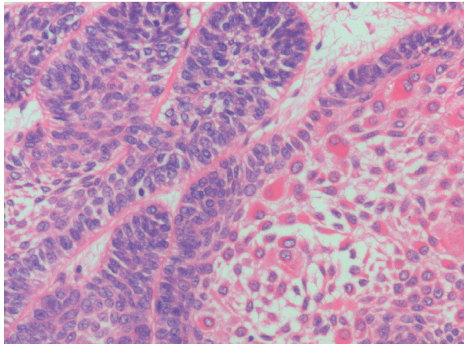
Figure 8: Photomicrograph showing follicles lined by tall co- lumnar cells enclosing stellate reticulum-like cells and squamous metaplasia (H&E 40x view).